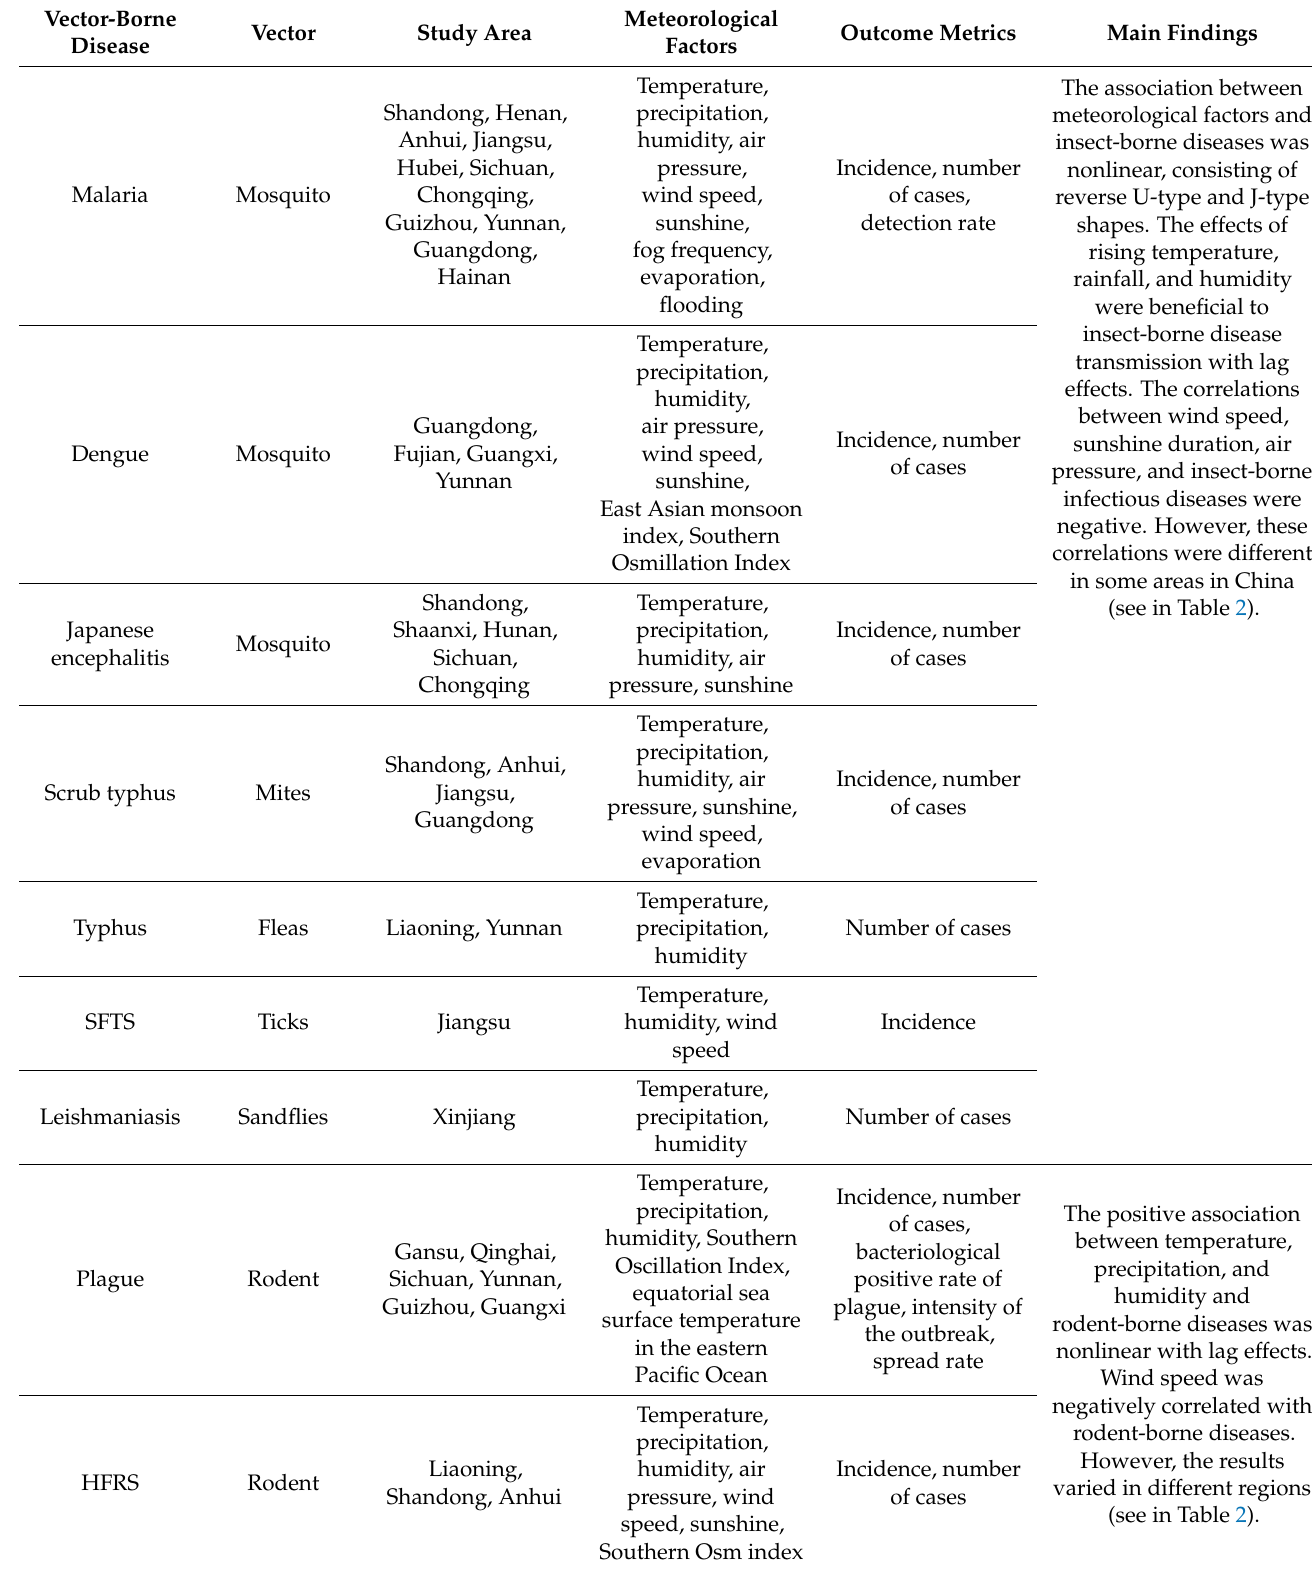
Table 1. Summary characteristics of research on meteorological factors and vector-borne diseases in